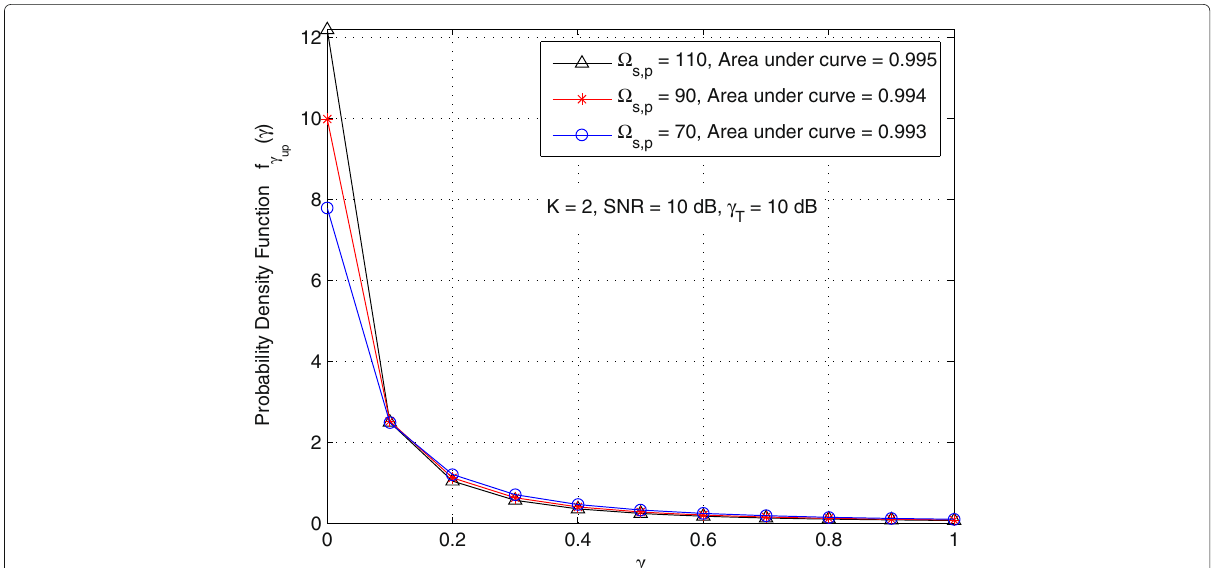
(γ) vs γ of cognitive AF relay network with MUSwiD user selection scheme for different values of (cid:3) Fig. 10 The PDF f γ up = 0.73, (cid:3) = 0.82 for k = (cid:3) r,p r, k